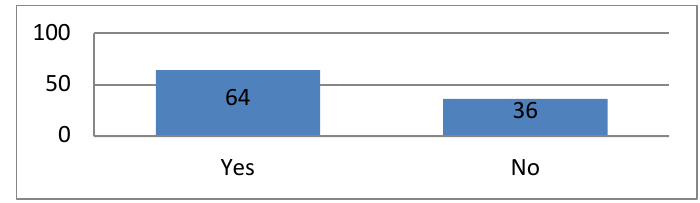
Figure 2: Have you held any management position in your